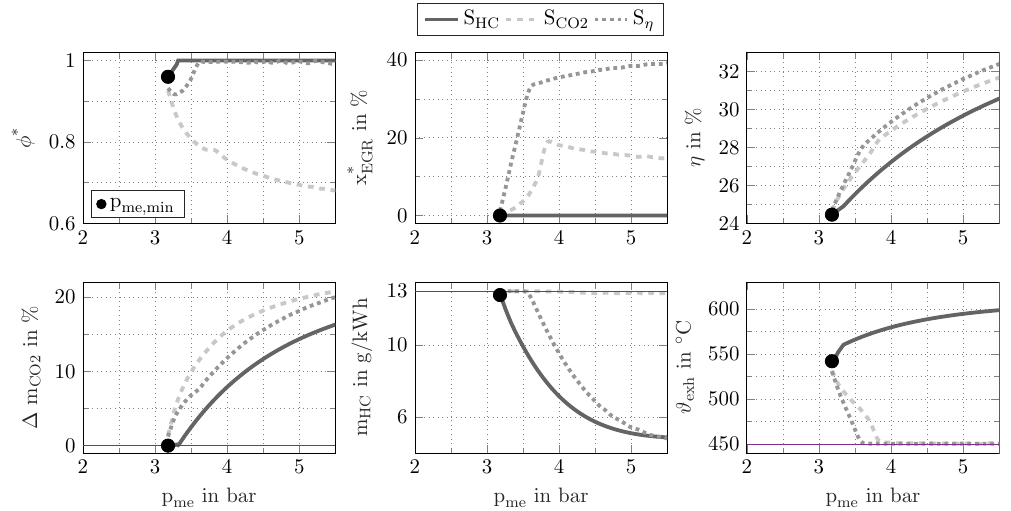
Figure 13. Results of simulations of three optimal strategies in terms of minimal HC emission ( S HC ), minimal CO 2 emission ( S CO ), and maximum efficiency ( S η ). 2